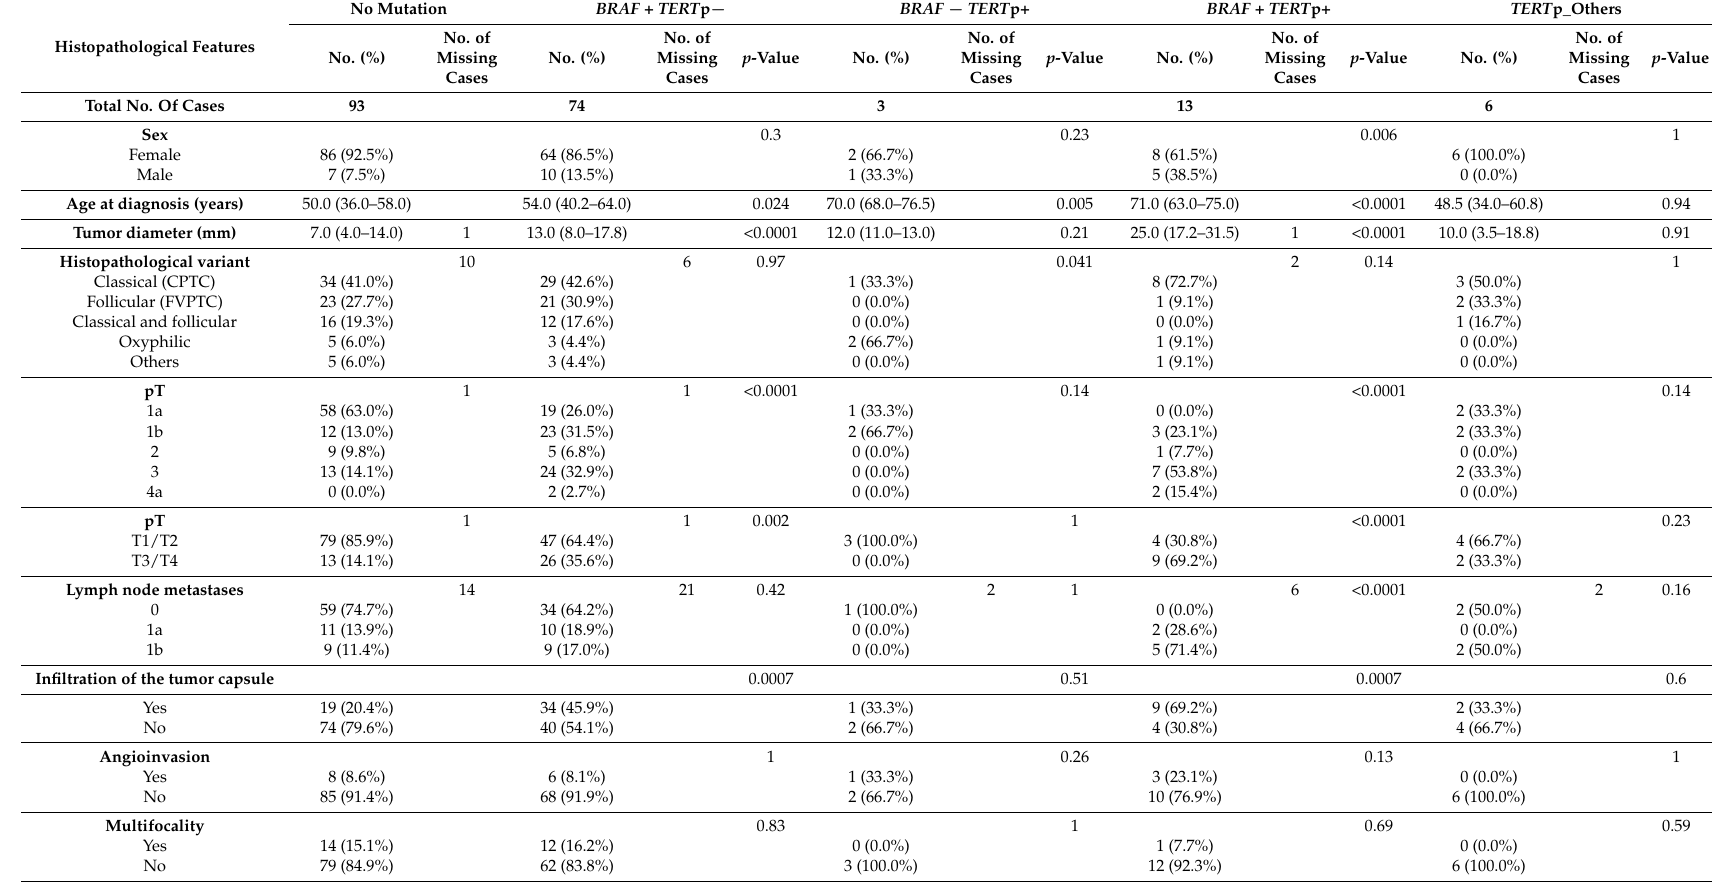
Table 2. Association of TERT promoter ( TERT p) hotspot mutations, the BRAF V600E mutation, their co-existence, and other TERT p alterations with histopathological features of the analyzed papillary thyroid carcinoma (PTC)